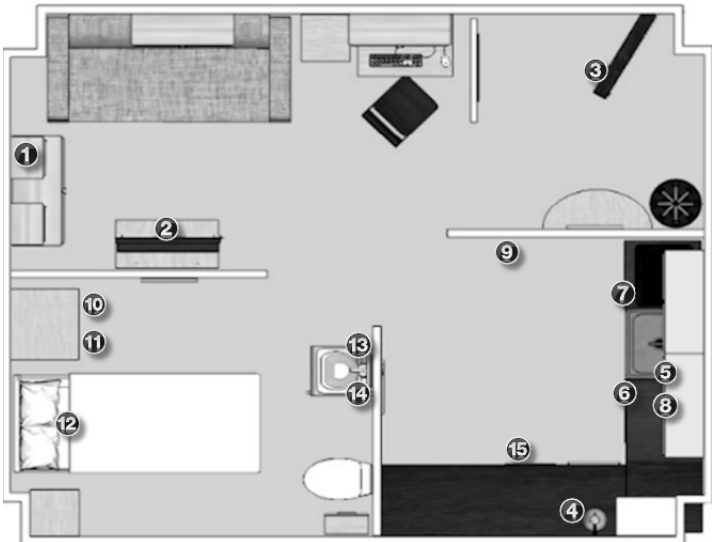
Figure 2. Location of Estimote Sticker beacons in the UJAmI Smart Lab. ( 1 ) TV controller, ( 2 )